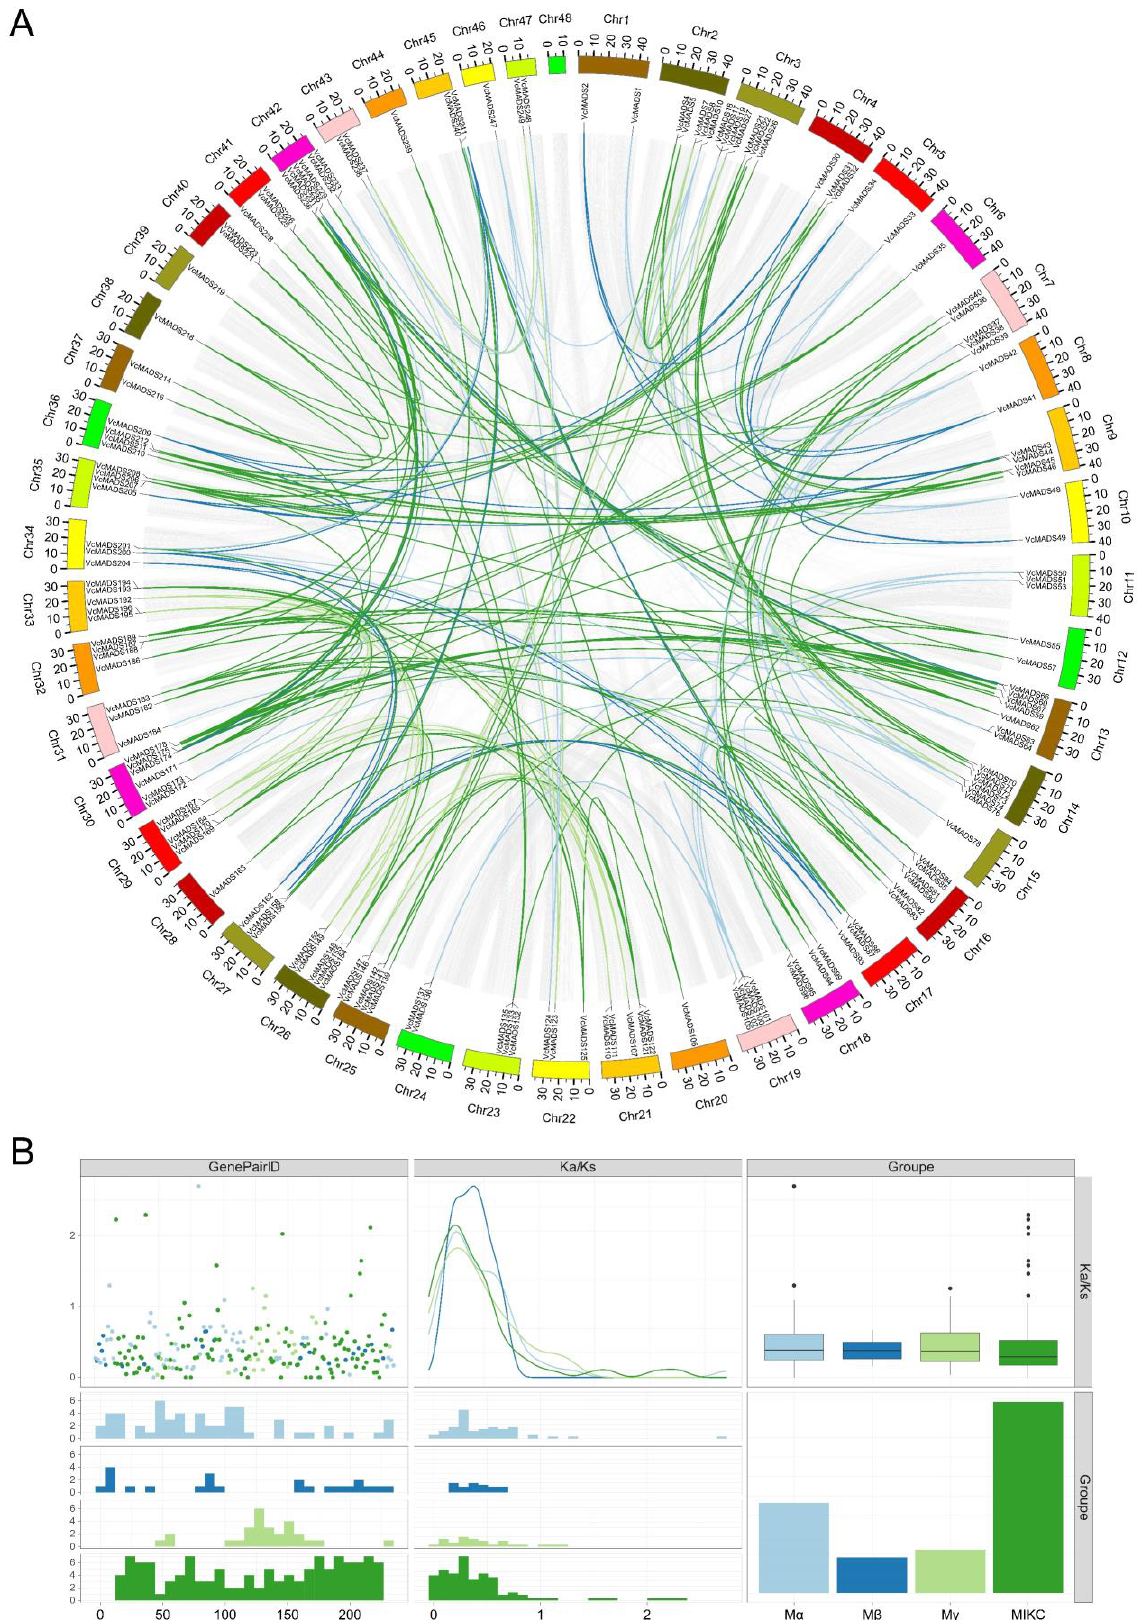
Figure 7. Collinearity of blueberry MADS-box genes and evolutionary selection pressure analyses. ( A ) The collinearity of the VcMADS genes. Light blue, dark blue, apricot, and green represent M α , M β , M γ, and MIKC family gene pairs, respectively. ( B ) The Ka/Ks distribution of gene pairs. Gene pairs belonging to different subfamilies are shown in light blue, dark blue, apricot, and green,